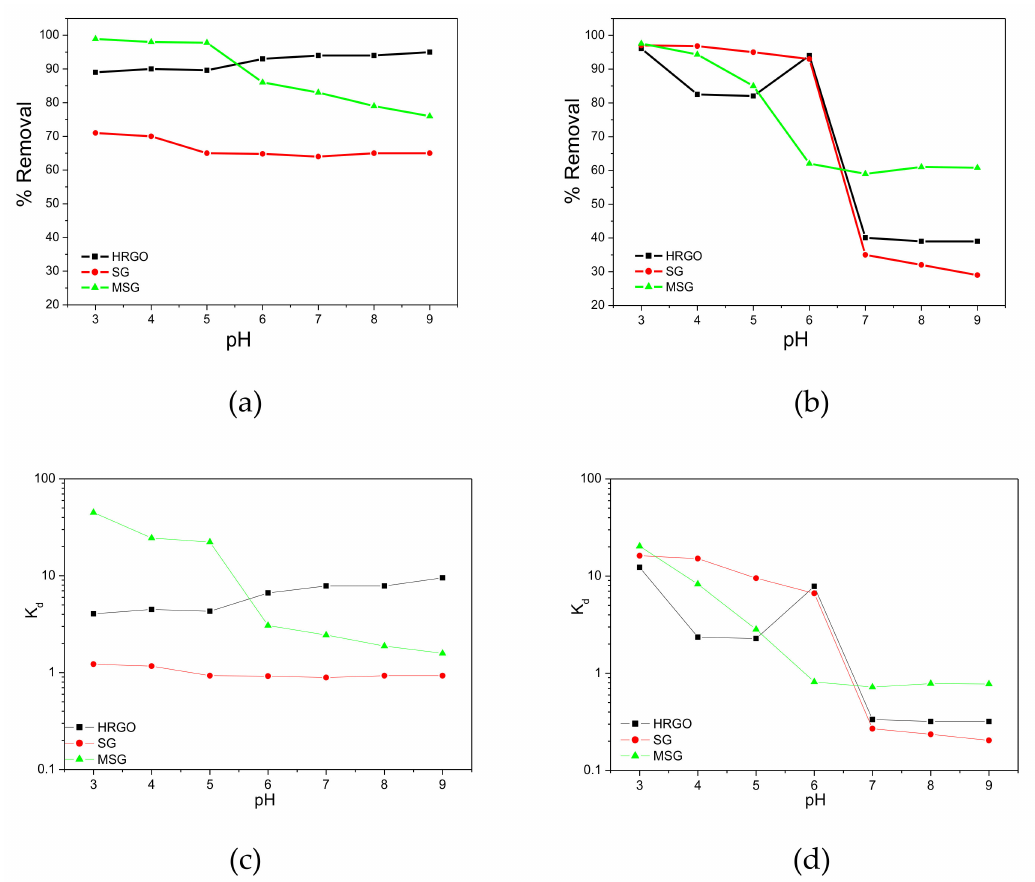
Figure 3. E ff ect of pH on the removal of: ( a ) Garamycin, ( b ) Ampicillin and e ff ect of pH on K d values for ( c ) Garamycin and ( d ) Ampicillin adsorbed onto HRGO, SG, and MSG [Experimental conditions: C 0 : 500 mg L − 1 ; dose of adsorbent: 2 mg mL − 1 ; temperature: 25 ◦ C; time: 30 min; volume: 50